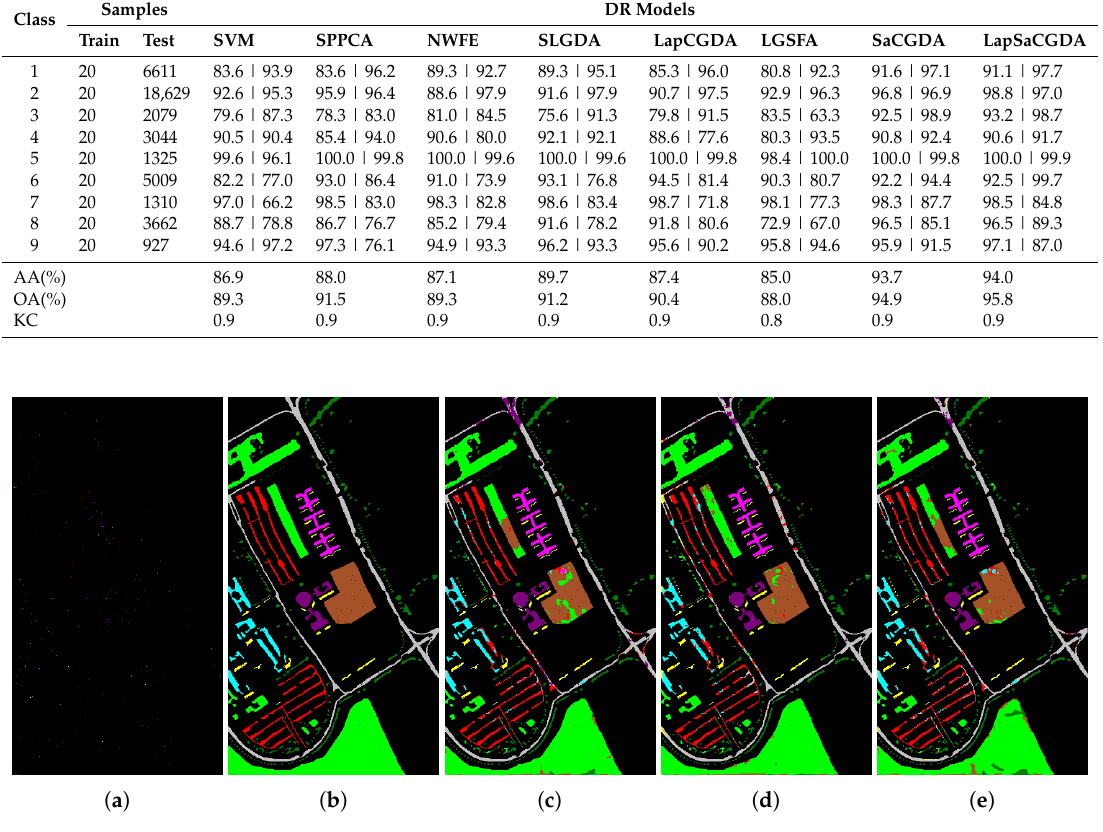
Table 3. Classification results of different DR methods based on SVM on the Pavia University data (the TPR and FPR of each class are displayed in the left and right sides of the vertical line, respectively).